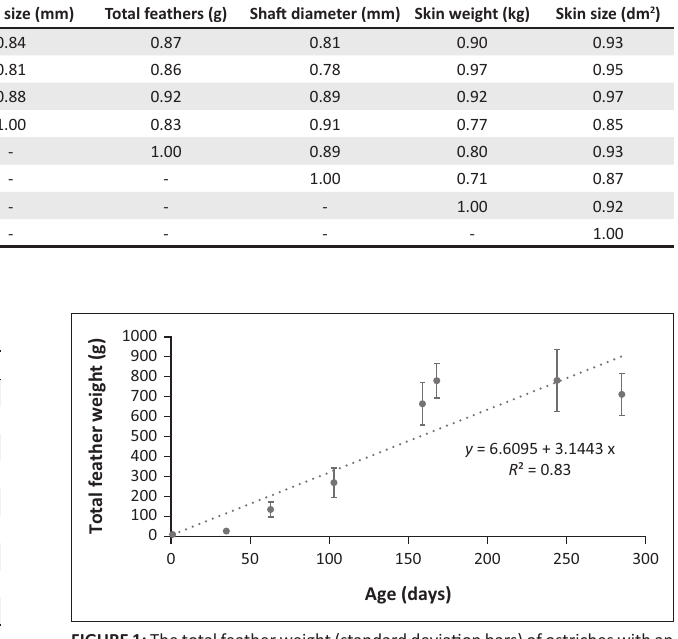
y = 4.7928 + 0.3783 x R ² = 0.95